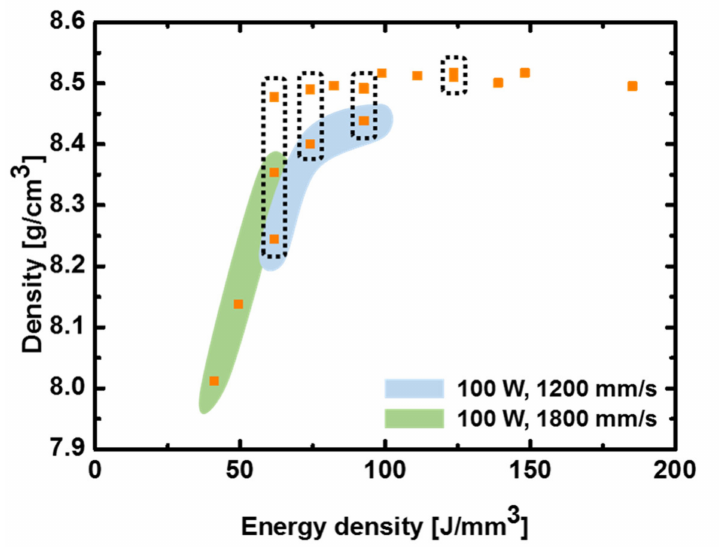
Figure 3. Dependence of CM247LC density on energy